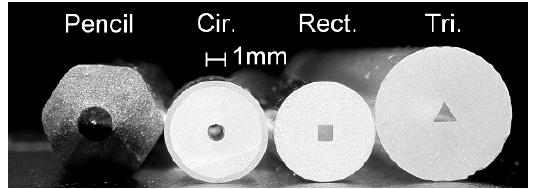
Figure 9. Test glass channels [14].